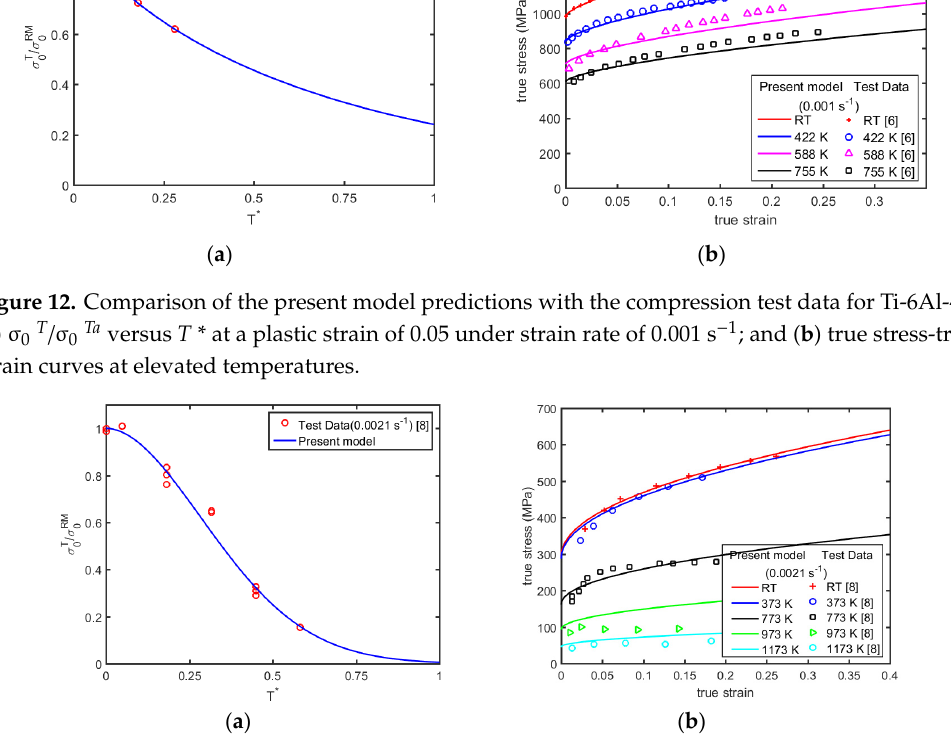
Table 1. The solid and broken lines represent Lode parameters of ξ = 1 (axisymmetric stress state) and ξ = 0 (plane strain state) respectively, the chain–dotted lines indicate the fracture loci for the plane stress state describing by the expression ξ = − 27